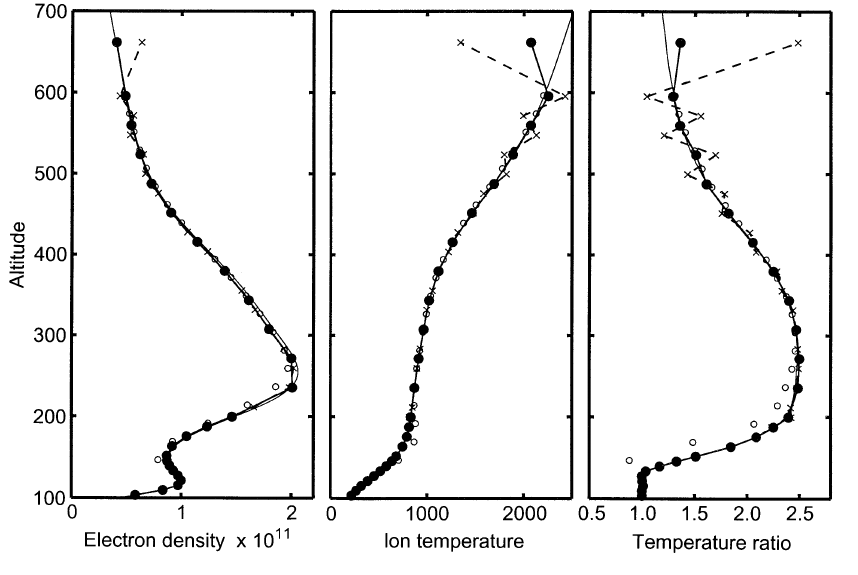
Fig. 7. Full-profile analysis results of simulated data. The parameter grid spacing is 6 km below the 150-km altitude, 12 km up to the 200-km altitude, and either 36 km ( full circles , solid line ) or 24 km ( crossed , dashed line ) above the 200-km altitude. The model parameter profiles are given by the thin solid line and the gated-analysis results of the long- pulse data by the open circle